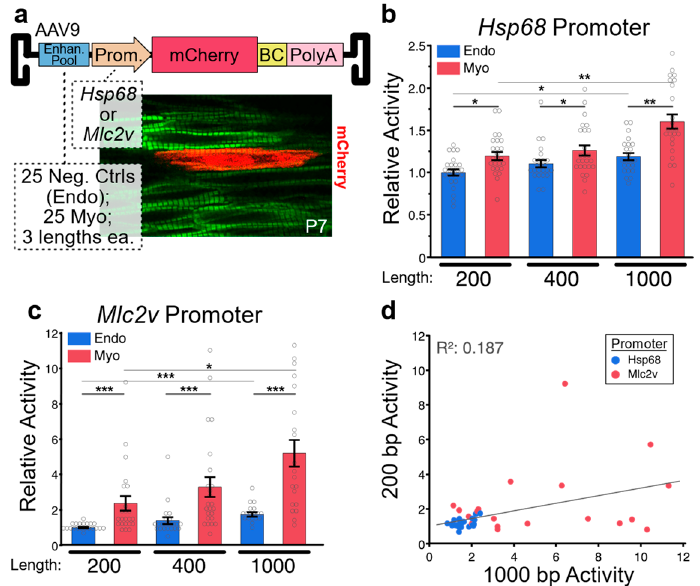
Figure 3. Effect of Enhancer Length on Activity ( a ) MPRA configuration. A library of 50 enhancers, each tested in three different lengths and with two different promoters (300 combinations), was packaged into AAV9 and delivered to newborn mice. Enhancers were selected from the VISTA Enhancer Browser of transgenic reporter data, and included 25 candidates active in the embryonic myocardium and 25 negative control candidates active in embryonic endothelium but not in myocardium. In the heart, AAV9 selectively transduces cardiomyocytes. Imaging of hearts from mice injected with the MPRA pool identified cardiomyocytes (green; Myh7 YFP ) with robust reporter expression (red; mScarlet) scattered throughout the myocardium. After collecting ventricles at P28, the reporter transcripts were sequenced, and the frequency of each barcode was compared to its frequency in the viral pool DNA. ( b ) When combined with an Hsp68 promoter, average myocardial enhancer activity was higher than endothelial enhancer activity at all lengths. Within both enhancer groups, longer enhancers generally displayed higher activity than shorter enhancers. ( c ) When combined with an Mlc2v promoter, average myocardial enhancer activity was again greater than endothelial enhancer activity at all lengths; however, the difference between the two enhancer groups was much more pronounced. Within both groups, longer enhancers once again displayed increased activity. ( d ) Correlation between 200 bp and 1000 bp activities for myocardial enhancers. Activities (RNA:DNA ratios) were normalized to the 200bp endothelial group average. Steel–Dwass p < 0.05 *, p ≤ 0.001 **, p ≤ 0.0001